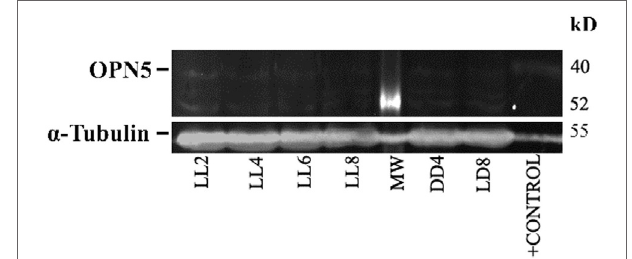
FigUre 5 | Analysis of Western blot of OPN4 protein expression in retina of animals exposed to light: (a) western blot immunolabeled OPN4 with a specific antibody showing the predicted isoform bands at different times of light treatment (LL, 1, 2, 4, 6, and 8 days) and controls in LD and DD during 8 days. The margin shows the molecular mass (right). (B) Relative expression of OPN4 normalized to α -Tubulin. Data are mean ± SD from three independent experiments; * p < 0.05 vs. DD4 by a non-parametric Kruskal–Wallis